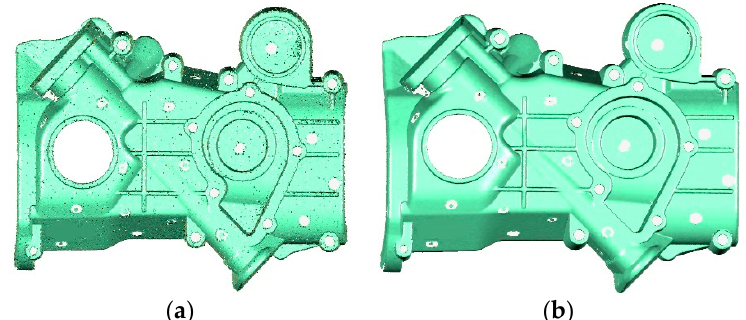
Figure 8. The comparison between the normal computed by Tubi ć et al. [6] and that filtered by our method; ( a ) normal before filtering; ( b ) normal after filtering.